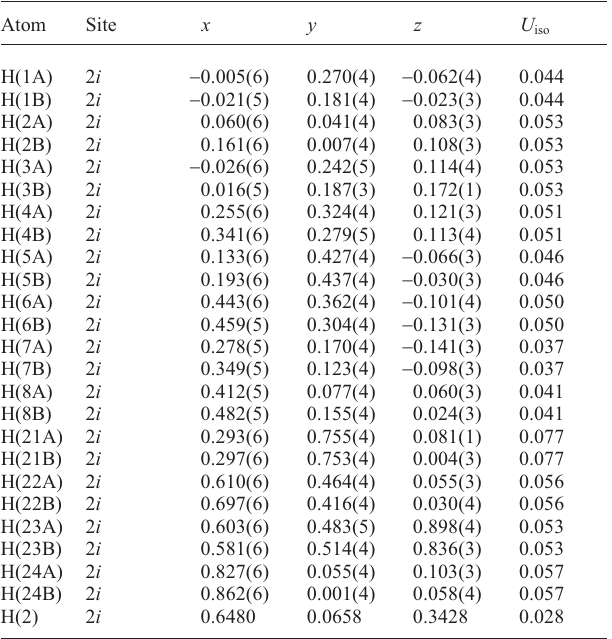
Table 2. Atomic coordinates and displacement parameters (in Å 2 )